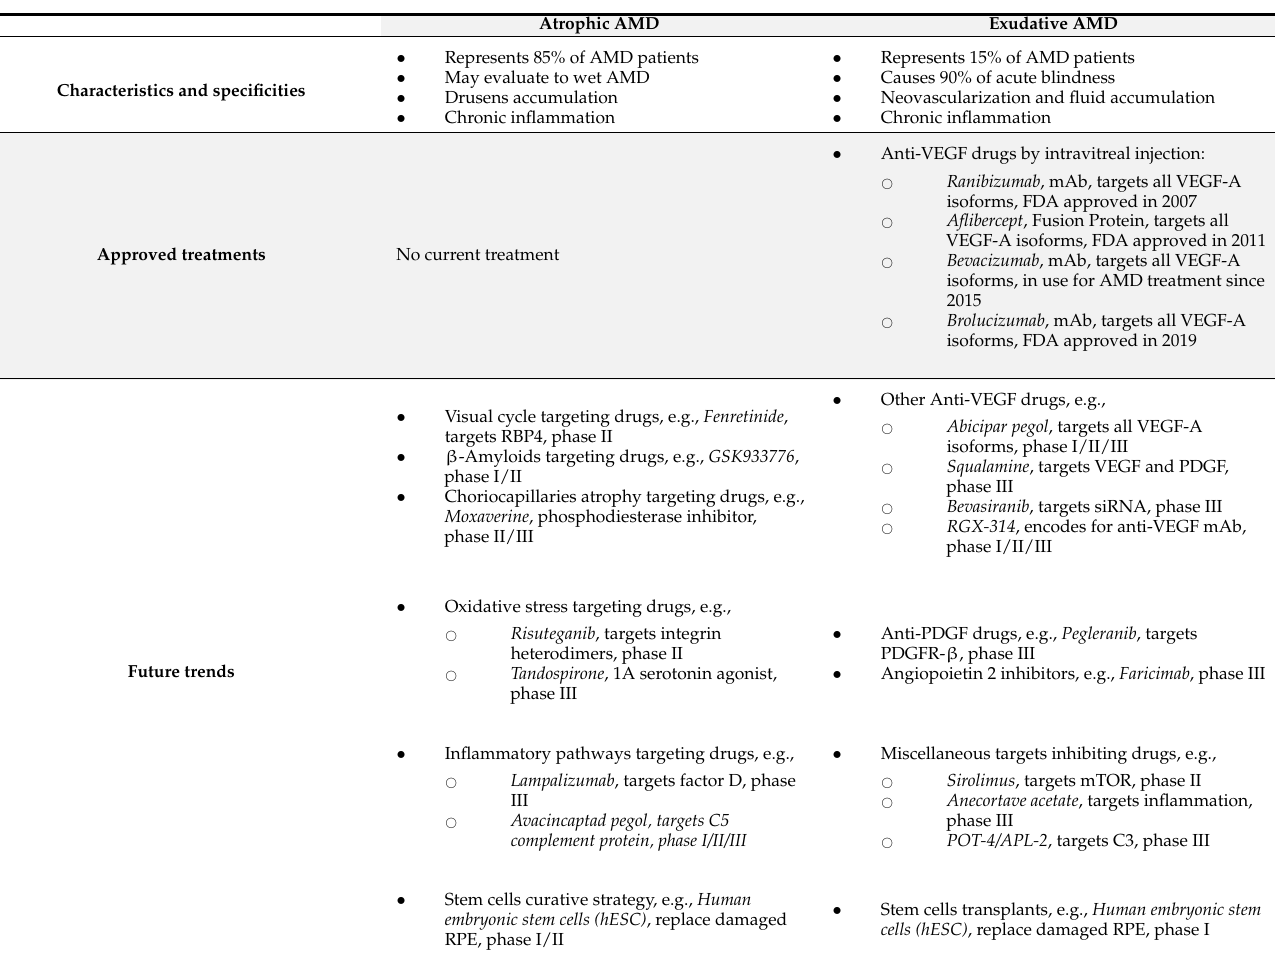
Table 12. The late AMD stages: divergences and convergences in physiopathology, current therapies, and future